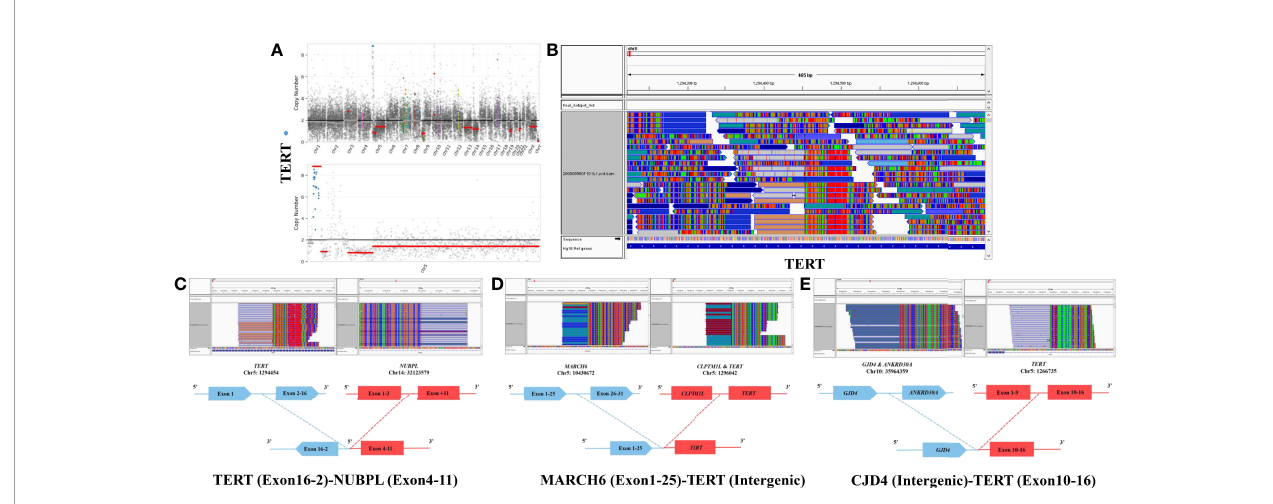
FIGURE 3 | Copy number variation (CNV) of the TERT gene was high in the whole genome (A) . TERT gene was ampli fi ed 8.94-fold on chromosome 5 (A) . Next generation sequencing (NGS) revealed signi fi cant TERT gene rearrangement (B) , including multiple TERT (Exon16-2) – NUBPL (Exon4-11) (C) , MARCH6 (Exon1-25) – TERT (Intergenic) (D) , and CJD4 (Intergenic) – TERT (Exon10-16) (E) fusions.